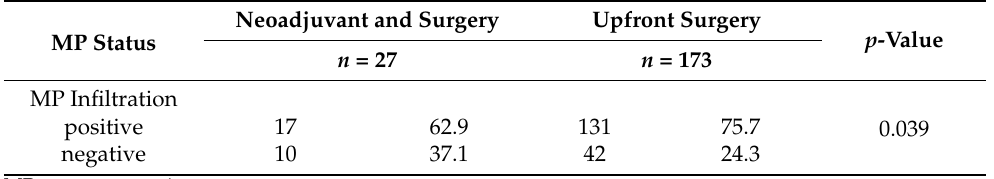
Table 5. Analysis of patients stratified according to neoadjuvant therapy followed by surgery ( n = 27) vs. upfront surgery n = 173. Mesopancreatic fat infiltration was heterogeneously distributed across the sub-groups. Statistical significance was calculated by chi-squared